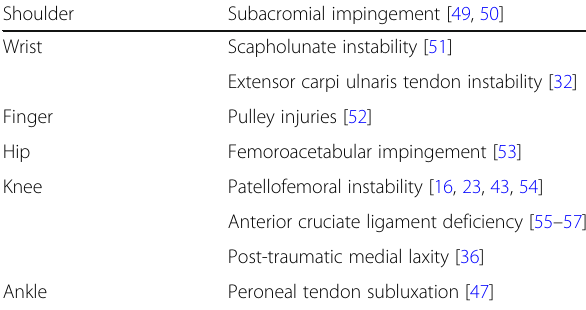
Table 3 Clinical applications of joint dynamic